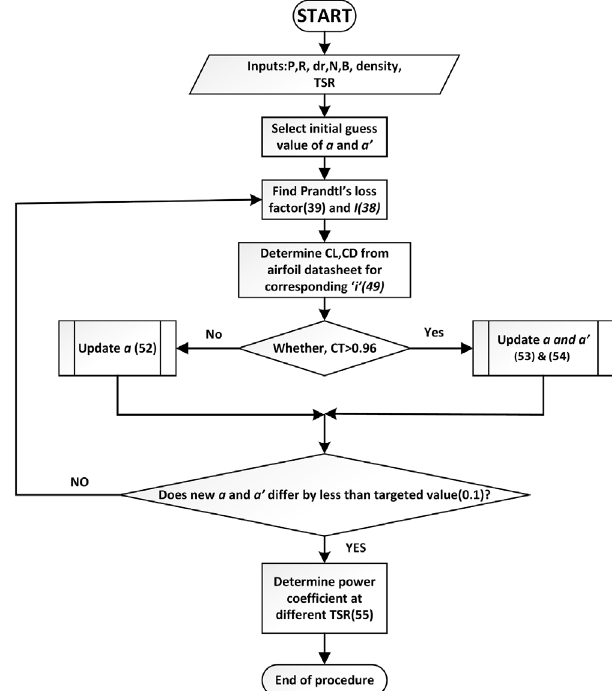
Figure 7. Design procedure for a 4 kW Small Wind turbine